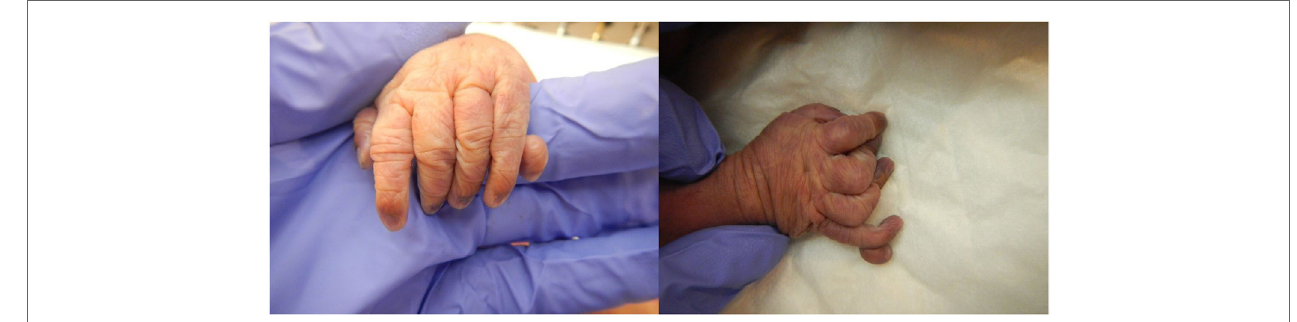
FIGURe 2 | postaxial bilateral hexadactyly .